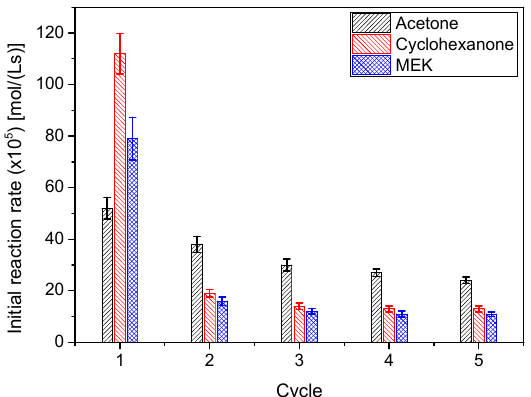
Figure 15. Evolution of the initial ketalization rates for all systems in subsequent reutilization cycles (System 1: acetone; System 2: butanone or methylethylketone (MEK); System 3: cyclohexanone). Reaction conditions: 25 °C, 50 g/L catalyst AC (system1); 40 °C, 200 g/L catalyst AC (system 2); 40 °C, 50 g/L catalyst AC (system 3); ketone/glycerol molar ratio = 6 (all systems).